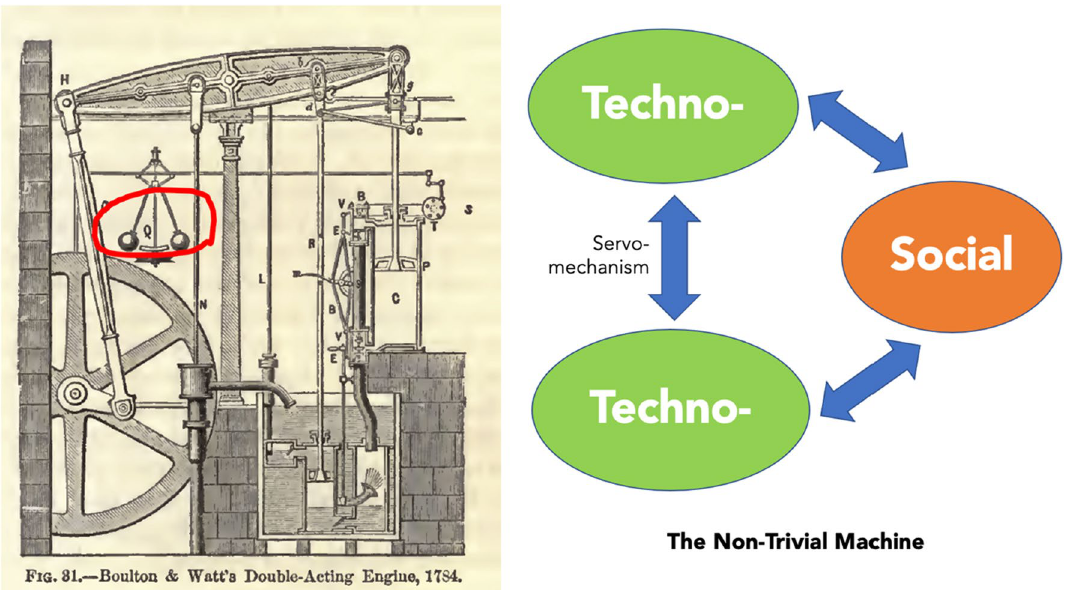
Fig. 7 A non-trivial machine—the governor (circled) on the Bolton and Watt Steam Engine acts as a